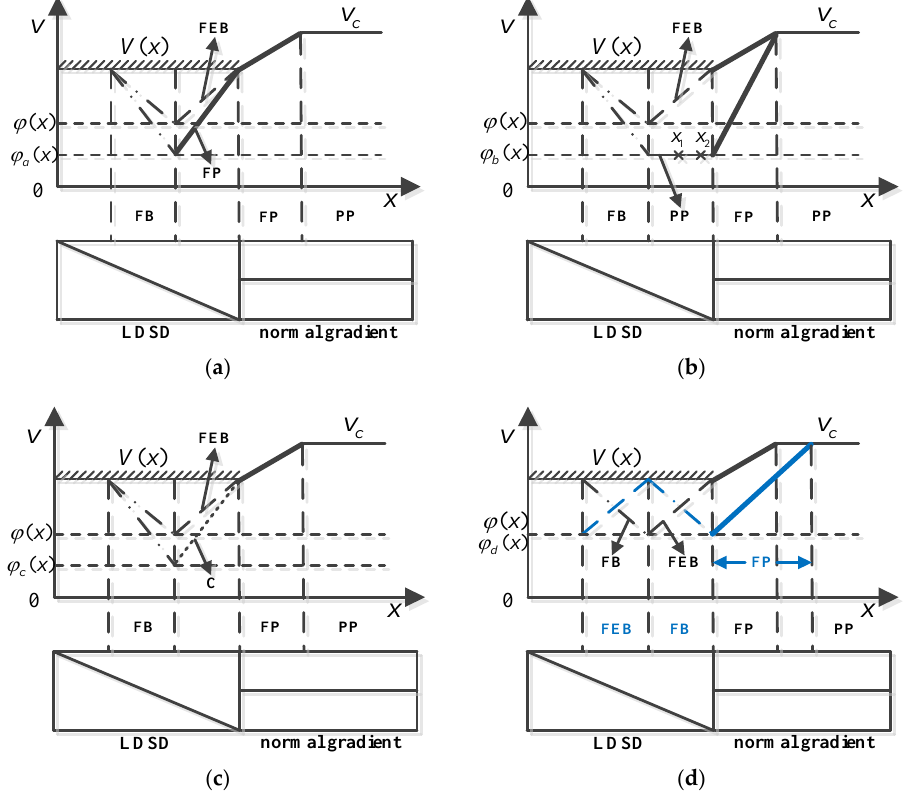
Figure 7. Comparative analysis of the optimal controls: ( a ) FEB and FP; ( b ) FEB and PP; ( c ) FEB and C; ( d ) FEB and FB.